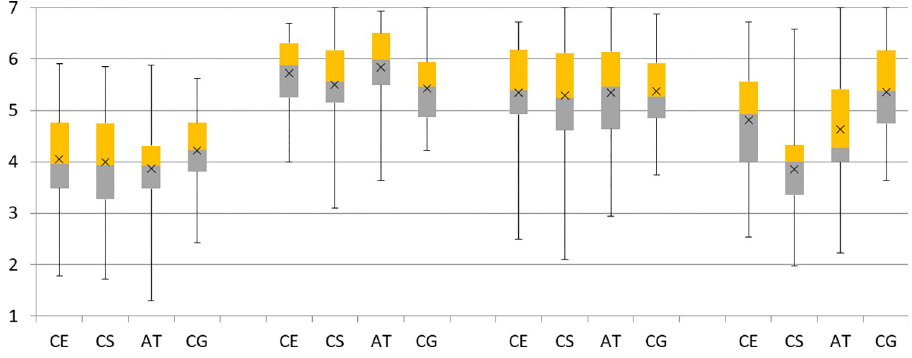
Fig 3. Boxplots of participants’ opinions (N = 251) for the debiasing treatment groups at each measurement time. The top of the upper whisker and the bottom of the lower whisker represent the maximum and minimum values, the top and bottom of the box represent the 75 th and 25 th percentiles, the line through the box represents the median, and the x marker represents the mean of the